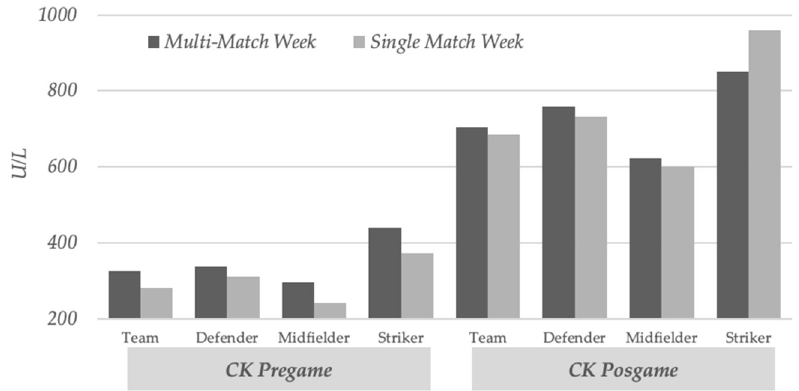
Figure 1. Muscle damage through creatine kinase analysis in multi-match vs. single-match weeks in soccer players that completed more than 60 min in the game and according to player position.